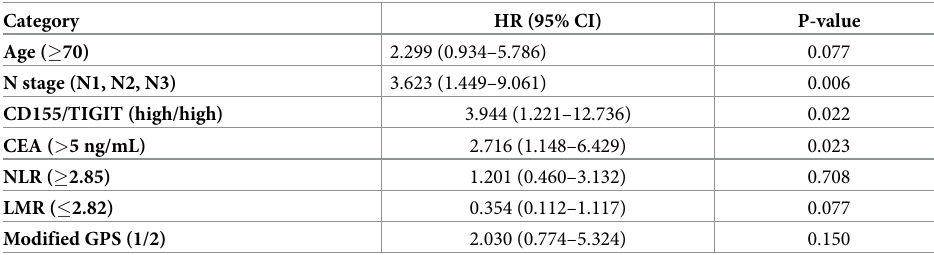
Table 5. Multivariate analysis for overall